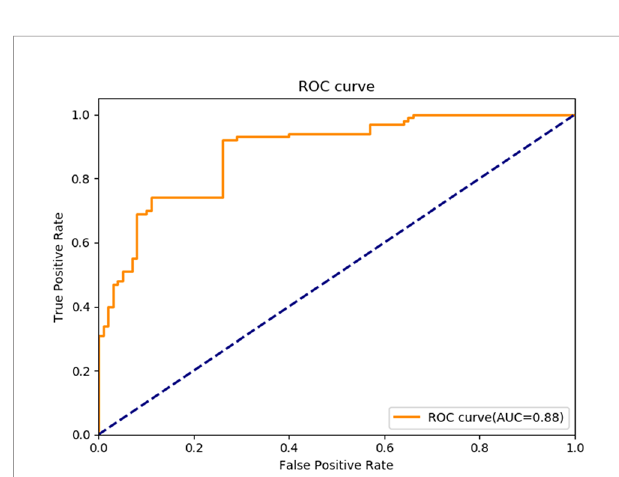
FIGURE 5 | Receiver operating characteristic curve of Faster R-CNN in diagnosing tumor budding. AUC, Area under the receiver operating characteristic curve; R-CNN, Region-based convolutional neural network; ROC: Receiver operating